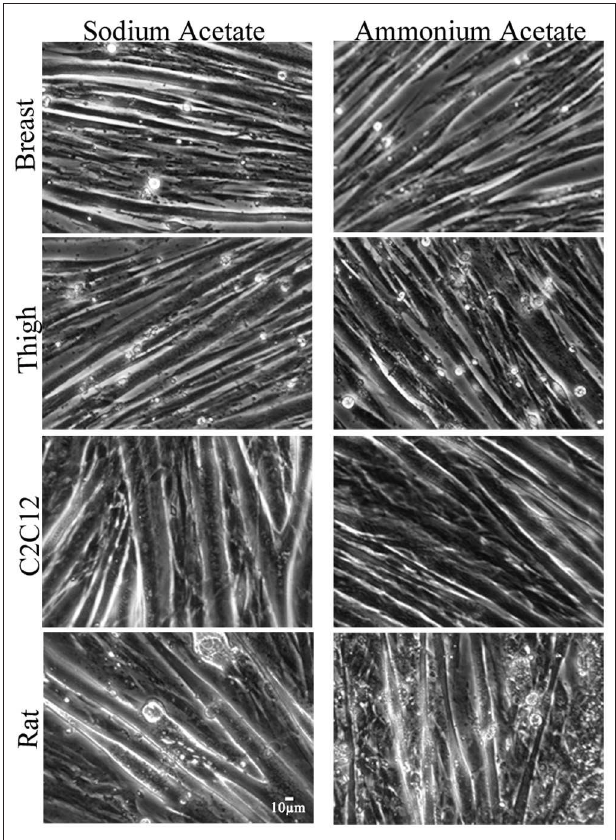
FIGURE 5 | Micropictograph myotube images. Representative micropictograph images of myotubes from primary breast, primary thigh, C2C12, and primary rat cultures after treatment with sodium acetate (10mM) or ammonium acetate (10mM) for